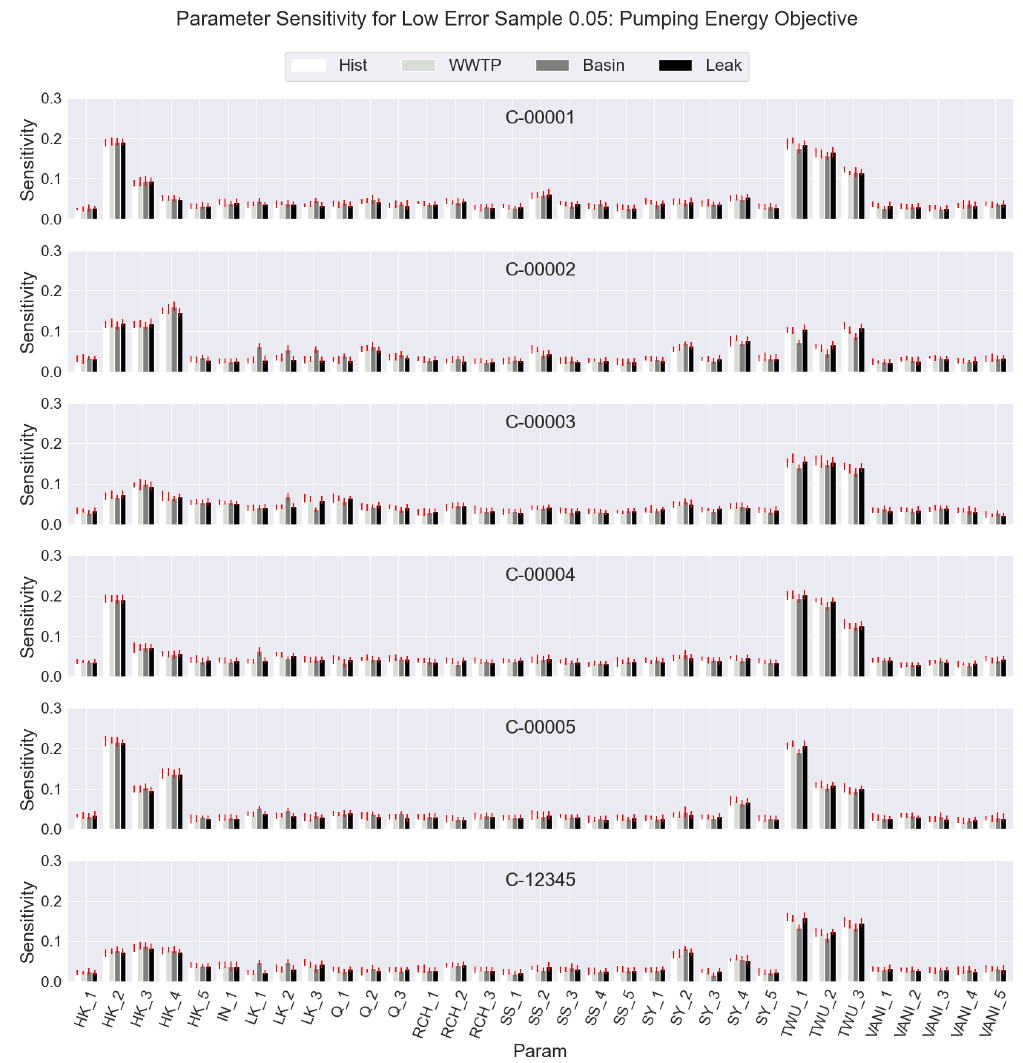
Figure 5. δ sensitivity of the energy objective according to the 5000 filtered samples for the 33 model parameters (columns). The sensitivity is shown by cluster (rows) and by the four alternatives, from left to right (light to dark), i.e., historical, wastewater reuse, infiltration basins, and repair leaks. The bootstrapped 95% confidence interval for each sensitivity value is shown as a red